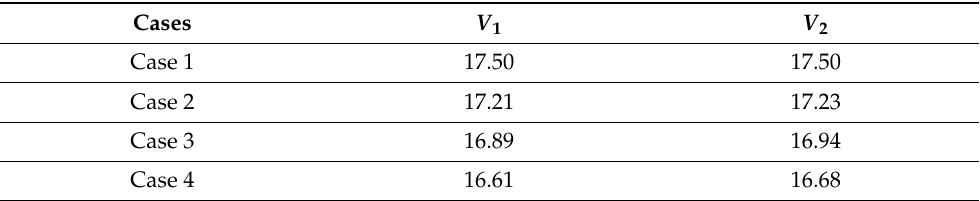
Table 3. Voltages across PV submodules for proposed SCL -based DPP topology for the mismatch cases in Table 2.